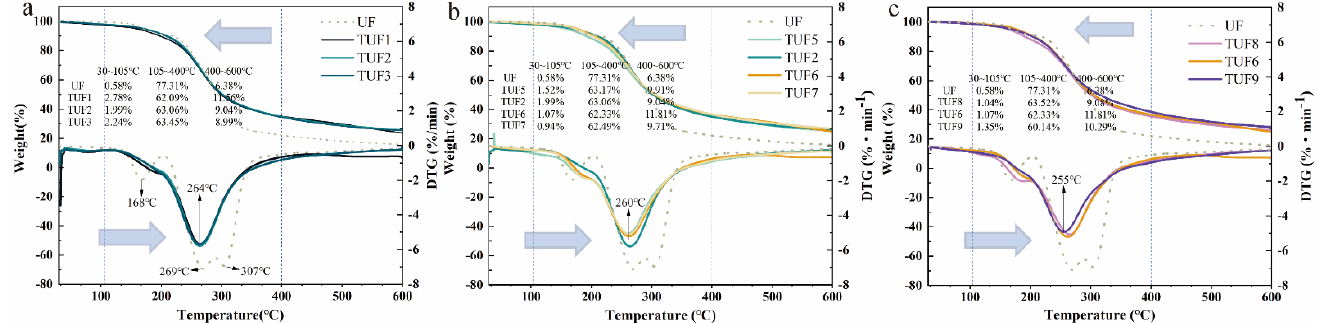
Figure 5. TG and DTG thermograms of UF and TUF resins prepared under varied reaction condi- tions. ( a ) reaction temperature; ( b ) reaction times; ( c ) tannin addition.